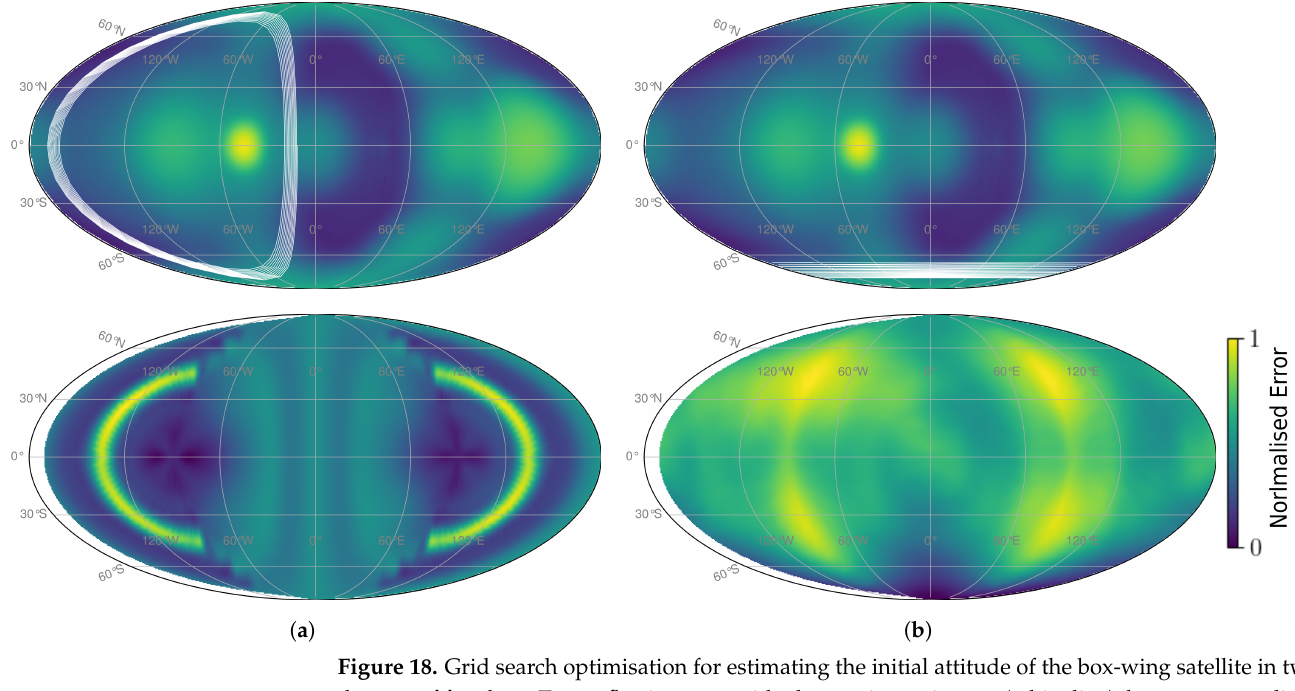
Figure 18. Grid search optimisation for estimating the initial attitude of the box-wing satellite in two degrees of freedom. Top: reflection map with observation trajectory (white line); bottom: normalised optimisation error. ( a ) Rotation axis pointing along the satellite antenna. ( b ) Rotation axis pointing along the wingspan of the solar